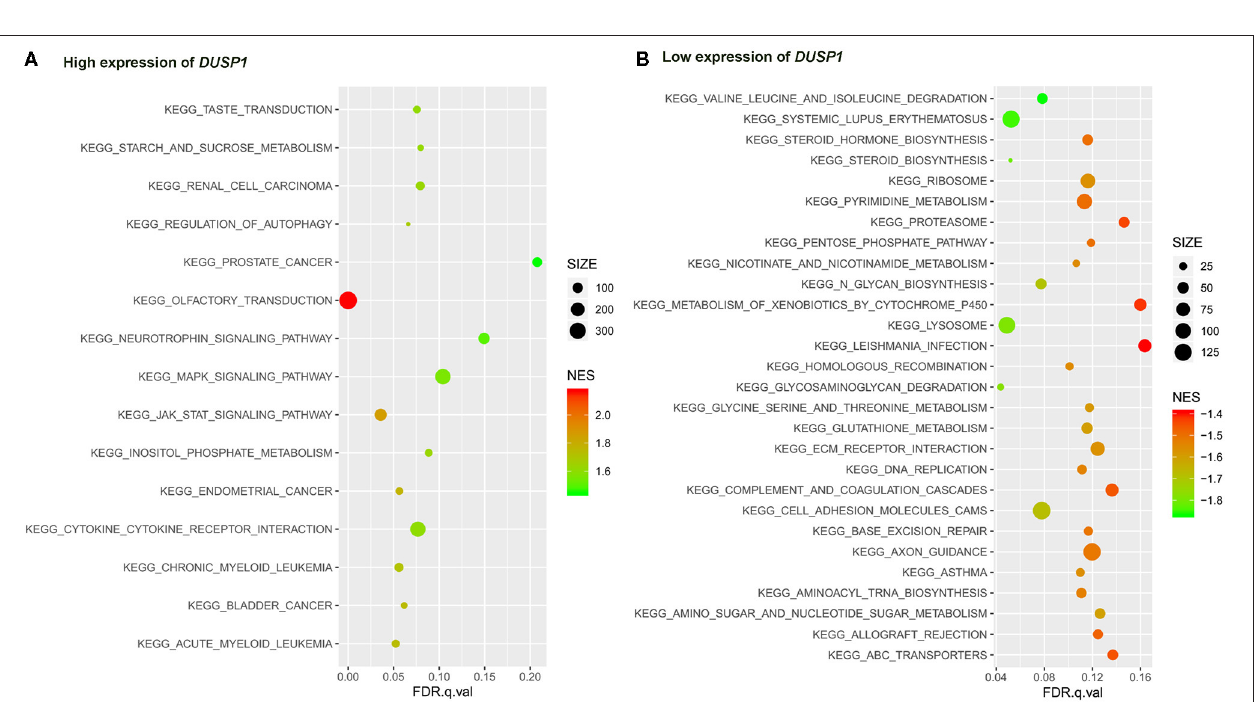
FIGURE 5 | The results of the GSEA on the biological processes. (A) Biological processes (Top 30) in the DUSP1 high-expression group and (B) biological processes (Top 30) in the DUSP1 low-expression group. The size of the node represents the number of genes under the gene set. The color of the node represents the NES of the gene set. The horizontal axis represents the level of q -value.